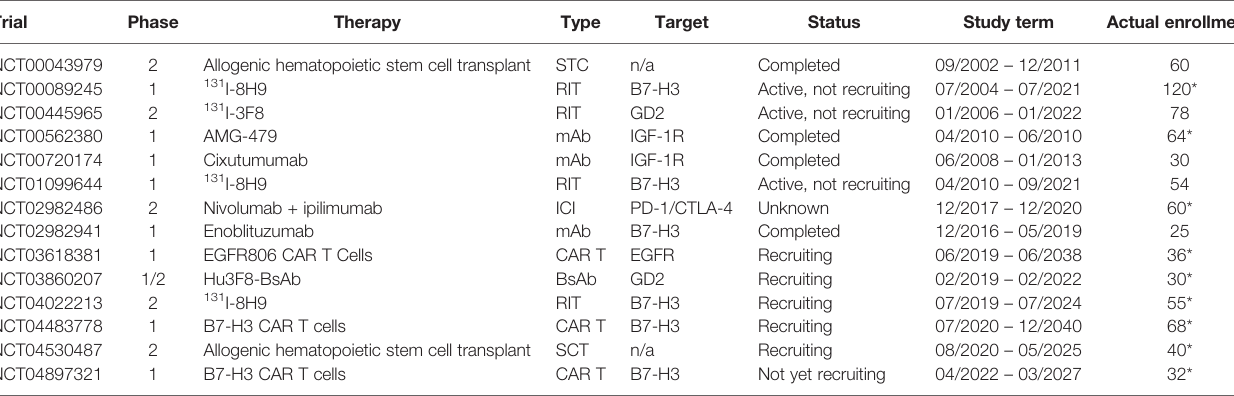
TABLE 3 | Previous and current clinical trials using immunotherapy to treat